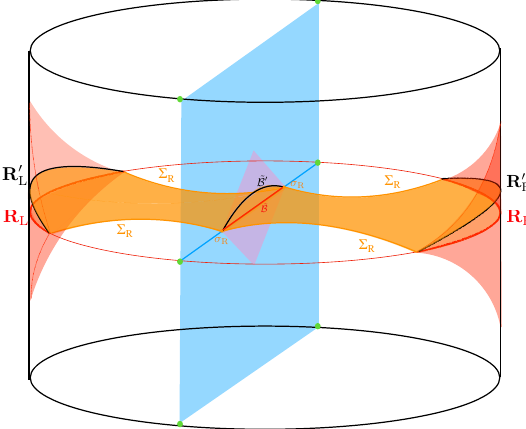
with the same ∪ R 0 L R . The red shaded regions R